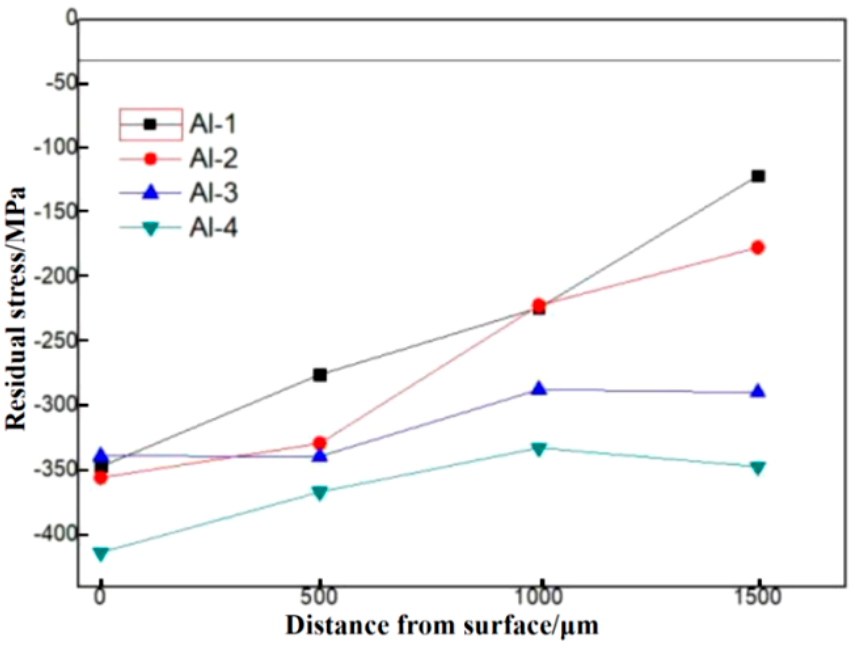
Figure 6. Comparison of the residual stress in different strengthening processes of the 7B04 alu- minum alloy.